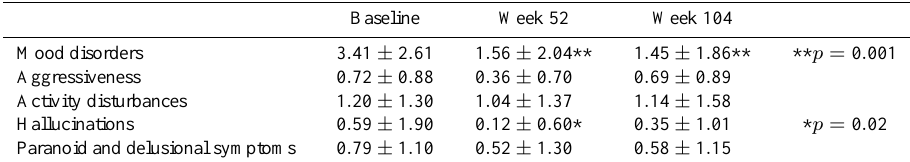
Table 3 Mean scores of the different behavioural domains during treatment (observed cases, n = 29). P -values refer to differences between mean rating scores at week 52 and 104 compared with